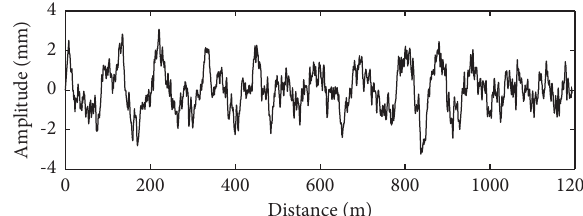
Figure 3: Sample of track vertical irregularities adopted in the